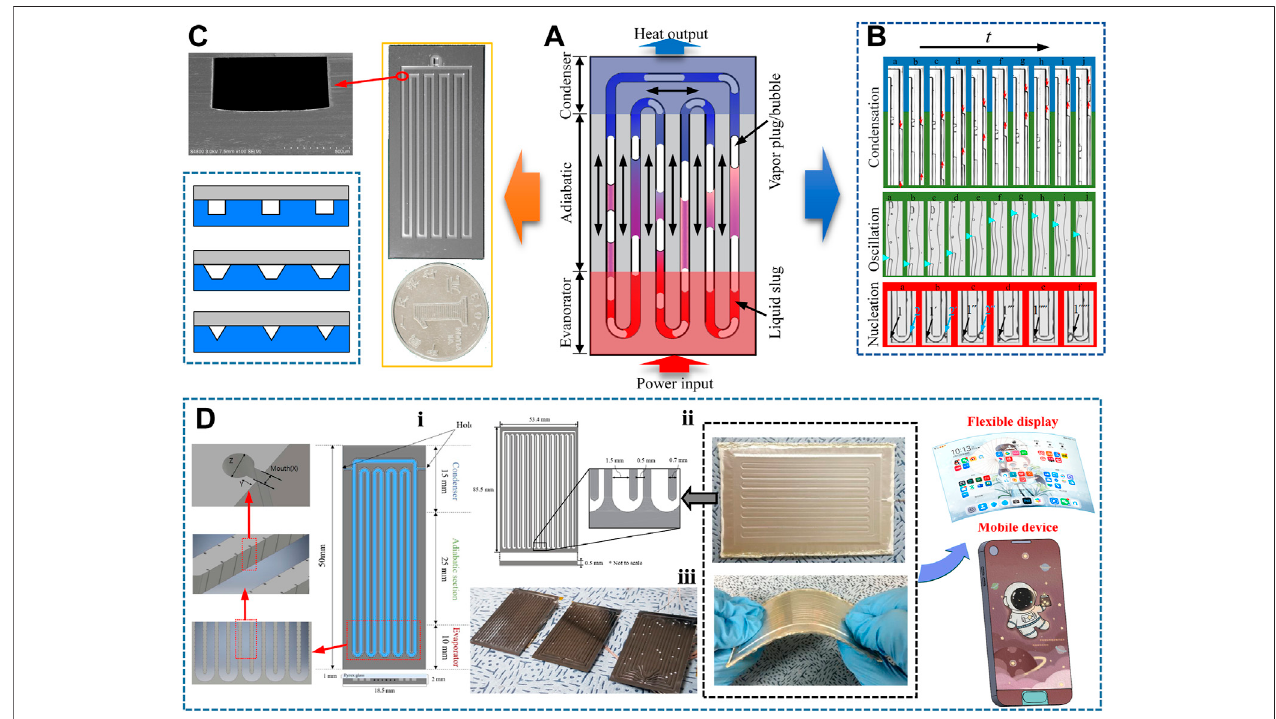
FIGURE 1 | Typical MOHPs and their characteristics: (A) operating principle of the MOHPs; (B) typical hydraulic characteristics in micro-channel; (C) photo of typical MOHPs and common section shapes of micro-channel; (D) developed MOHPs with practical value (Kim W. and Kim S. J., 2018) i , (Lim and Kim, 2017; Lim and Kim, 2018; Jung et al., 2020) ii , (Lim and Kim, 2017; Lim and Kim, 2018; Jung et al., 2020) iii